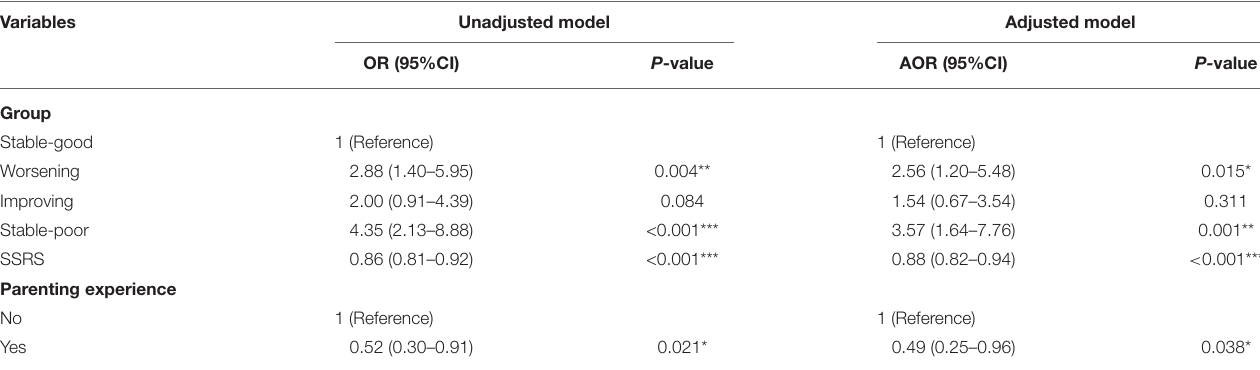
TABLE 4 | Multivariate logistic regression for risks of postpartum depression